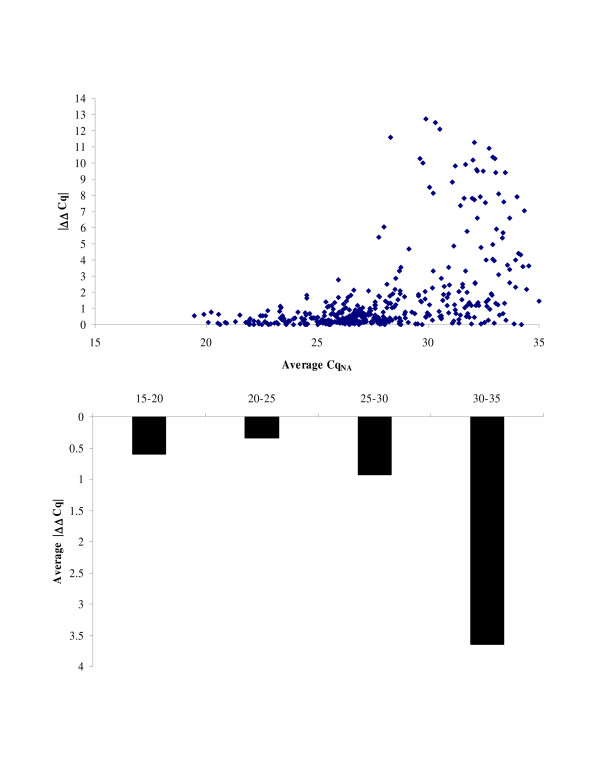
Plot of the difference in differential T-UCR expression between LAN-5 and GI-ME-N cell lines against each mean dCqNA value. Bar plot shows the mean |ΔΔCq| value for T-UCRs with an average CqNA value ranging between 15-20, >20-25, >25-30, and >30-35 cycles.